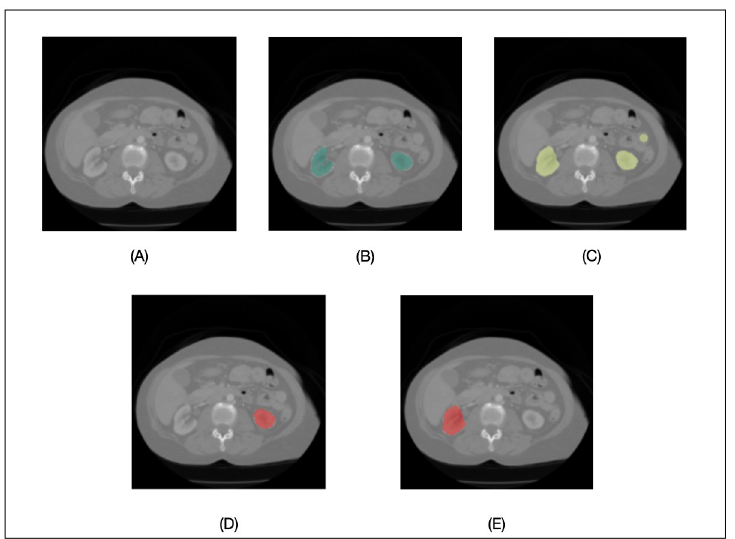
Fig 3. Kidney segmentation on CT. Kidney segmentation on CT: (A) original image; (B) reference kidney segmentation (green overlay); (C) segmentation result for the kidney_cnn node using a DNN alone (the baseline results); (D) SimpleMind segmentation of the right_kidney node (red overlay); (E) SimpleMind segmentation of the left_kidney node (red